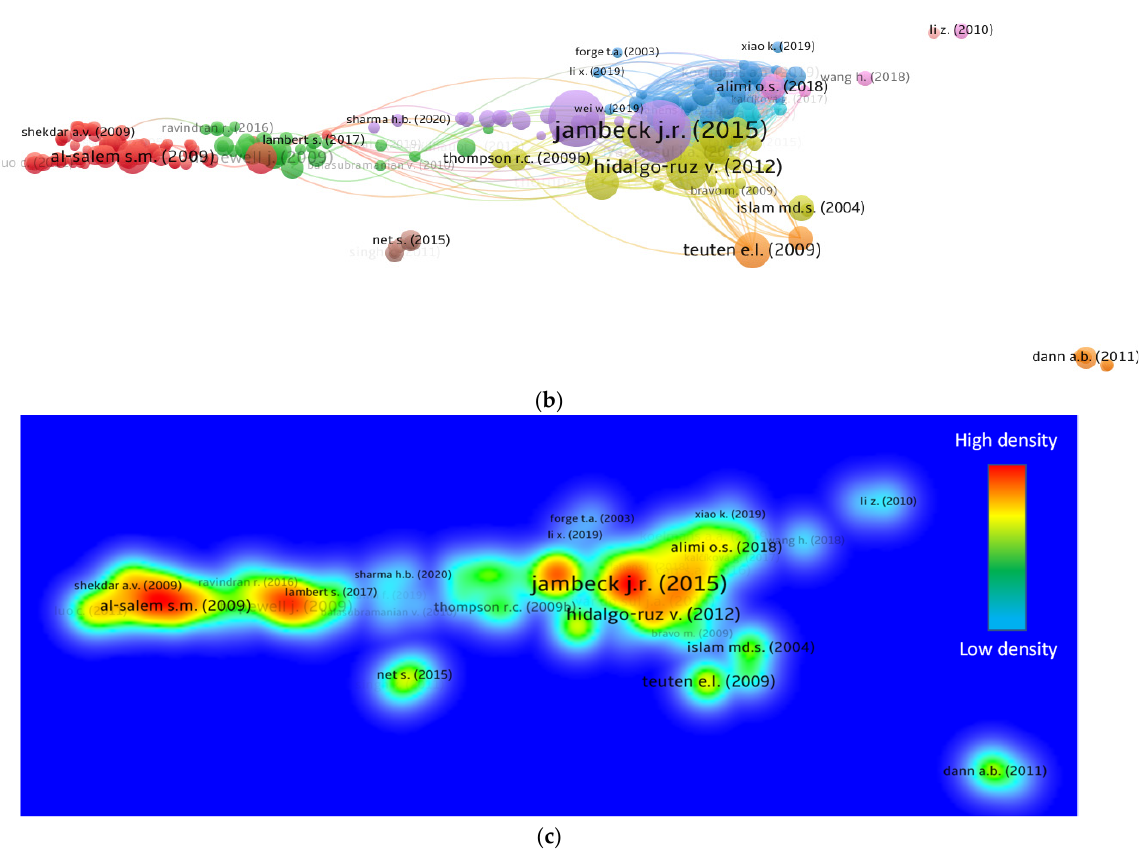
Figure 9. Scientific visualization of documents: ( a ) Documents with a minimum of 100 citations; ( b ) Linked documents based on citations: circle size is proportional to the number of co-occurrences of a particular keyword, and different colors show distinct clusters formed based on the pattern of co-citations; ( c ) Density of linked documents.